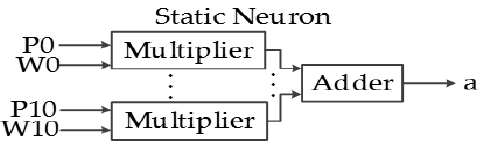
Figure 19. Static neuron hardware.